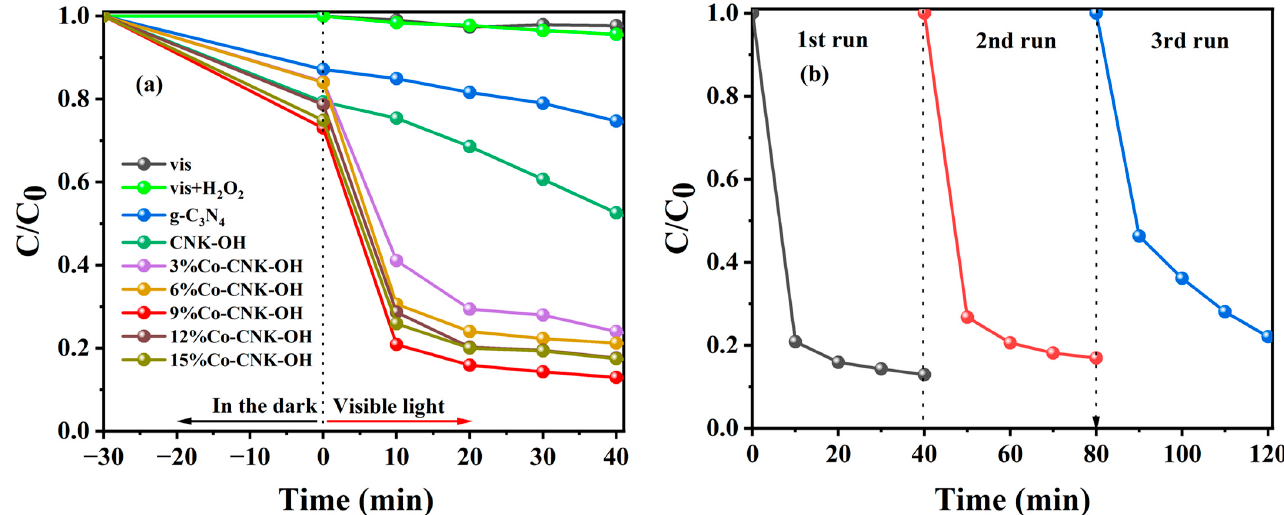
Figure 9. Degradation curves of TC in different reaction systems ( a ), cycle test of 9%Co-CNK-OH for TC degradation ( b ). Reaction conditions: catalyst dosage: 50 mg L − 1 , H 2 O 2 : 30 mM, pH: 7, and TC: 20 mg L − 1 .